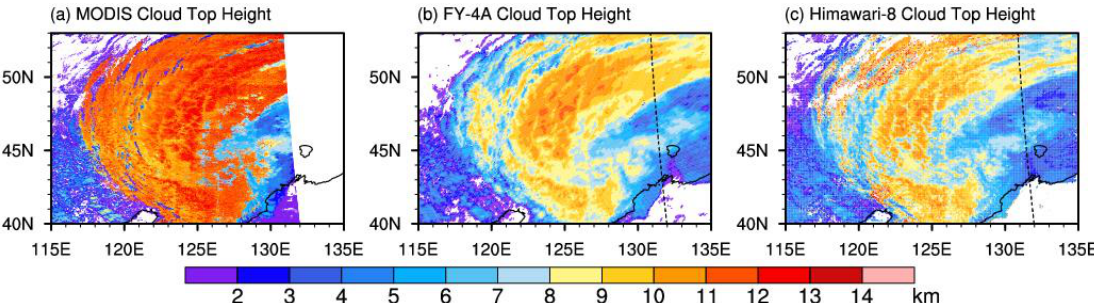
Figure 2. Example of the quasi-simultaneous observations of MODIS, FY-4A, and Himawari-8 in the study area at 05:15, 05:15, and 05:10 UTC on 8 September 2020, respectively. The black dashed lines in ( b ) and ( c ) are the orbital boundaries of MODIS in ( a ).